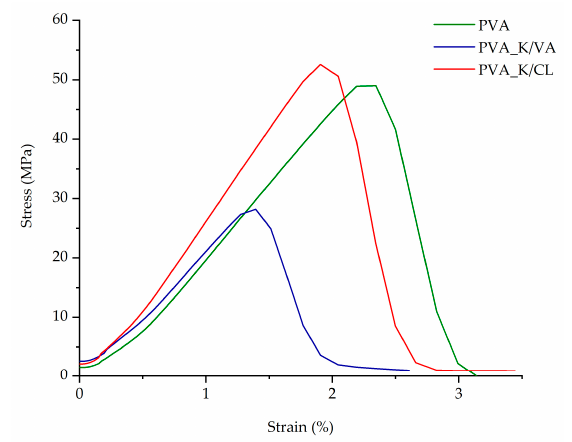
Figure 2. Comparison of the mechanical strength and resilience of the filaments.